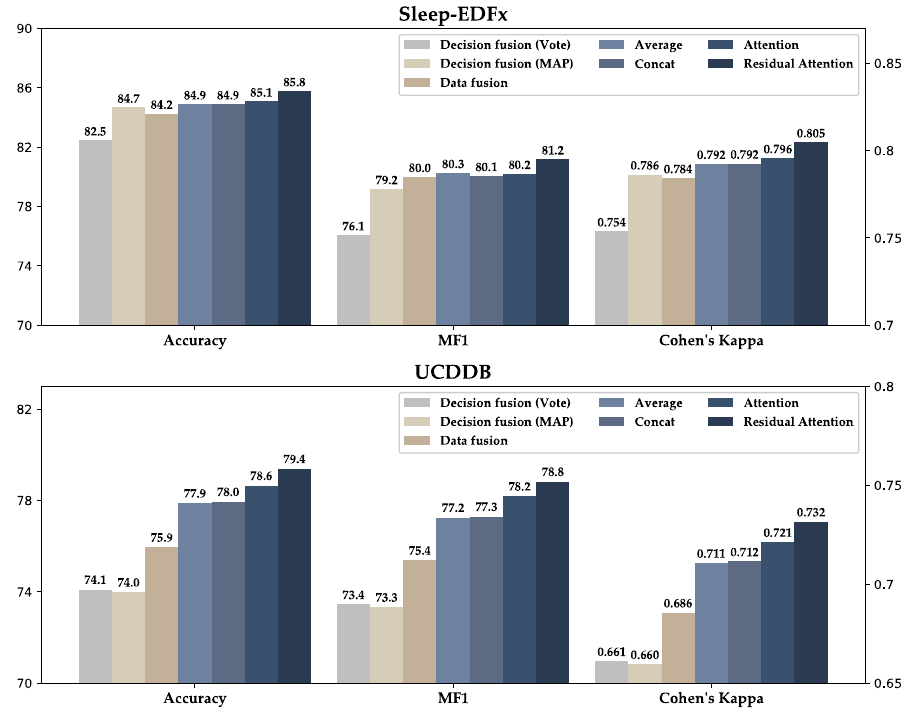
ff erent channel fusion